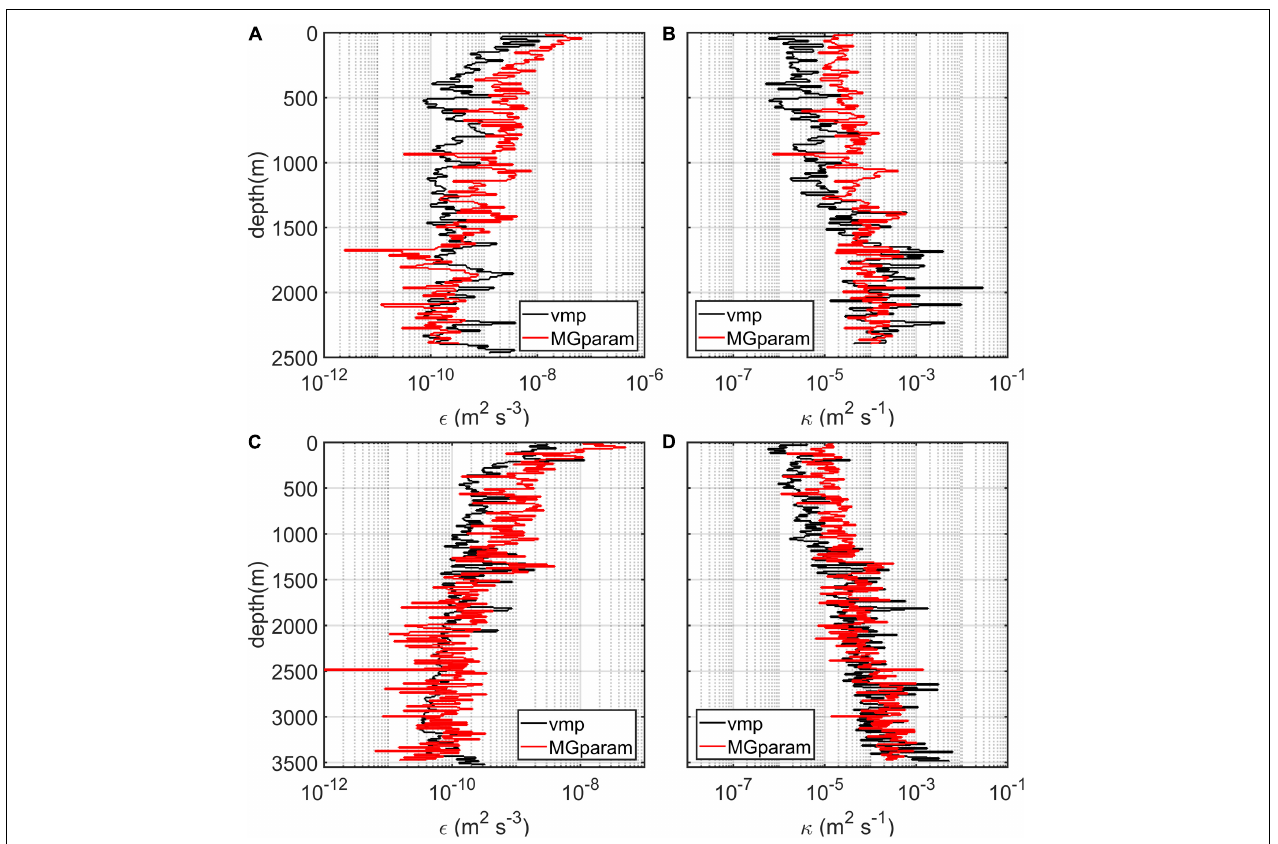
FIGURE 9 | (A,B) Profiles of the turbulent dissipation rate and diffusivity from the observations (black solid lines) and MG parameterization (red solid lines) at P2. (C,D) Similar profiles except at P3.